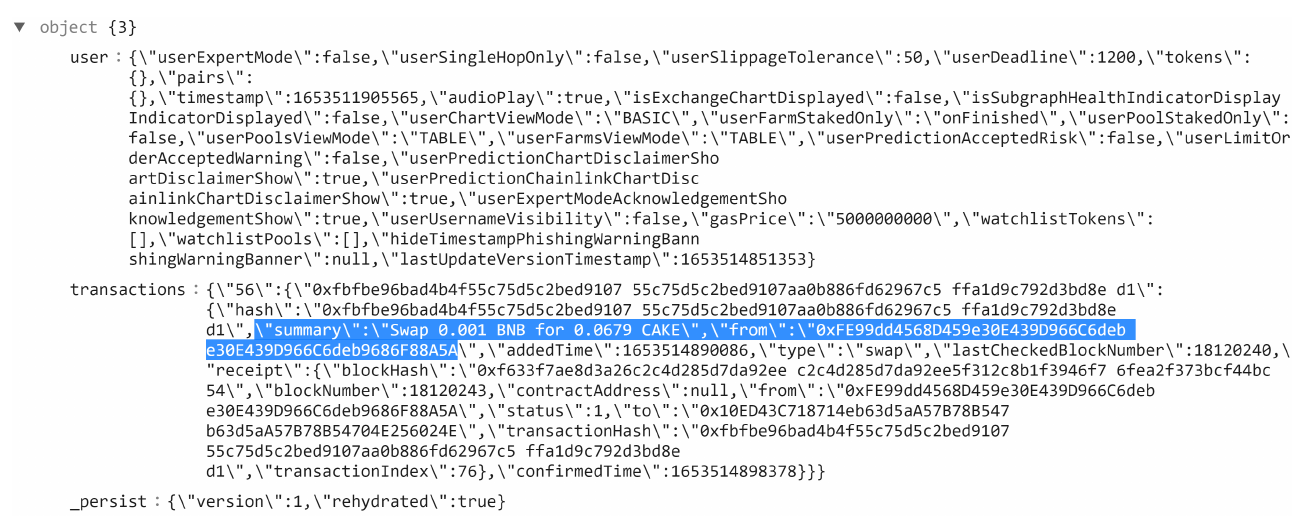
Figure 30. The 000003.log within the Local Storage of the app web view that kept activities of swap